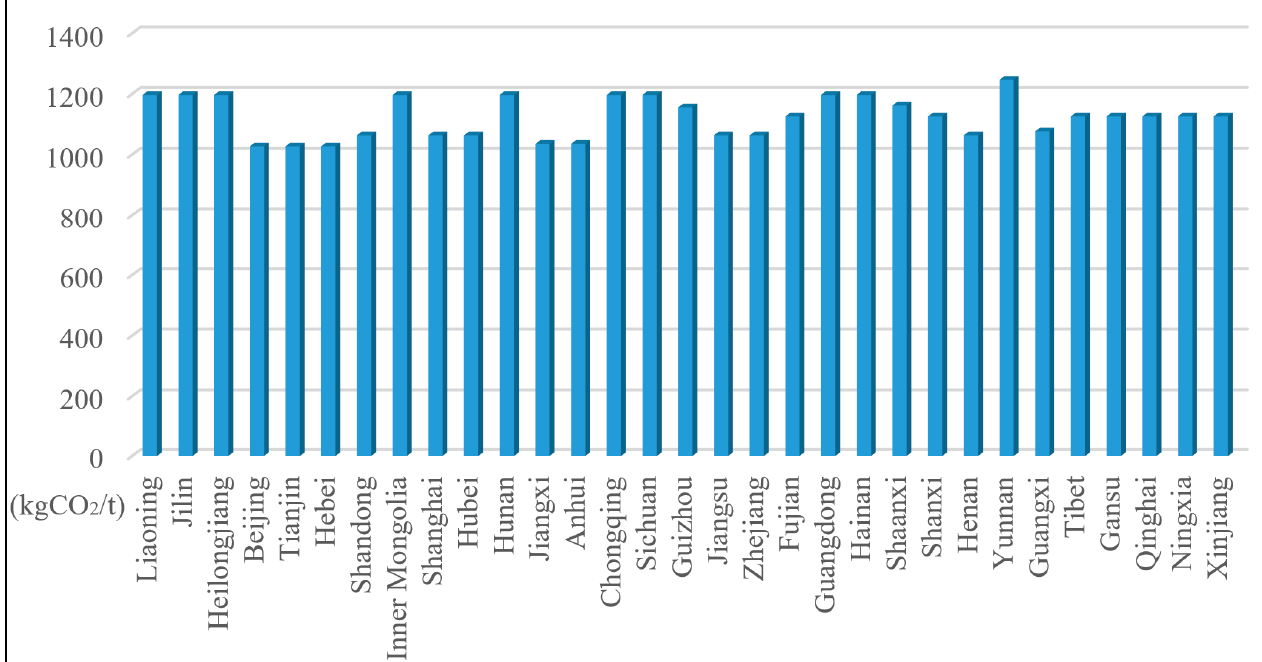
Figure 5. Carbon factors of cement production in 31 provinces.